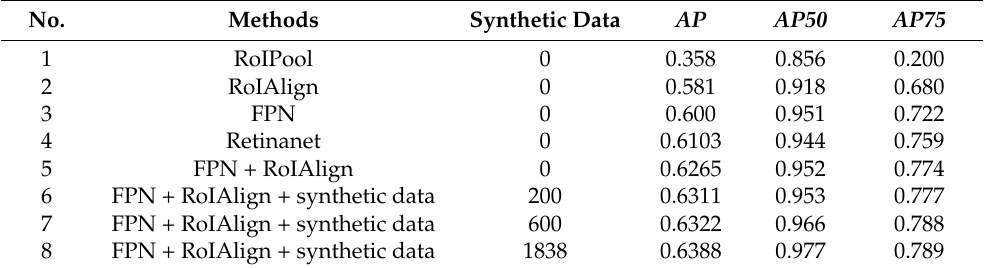
Table 1. Comparison of the labeled oil detection results in the training set.